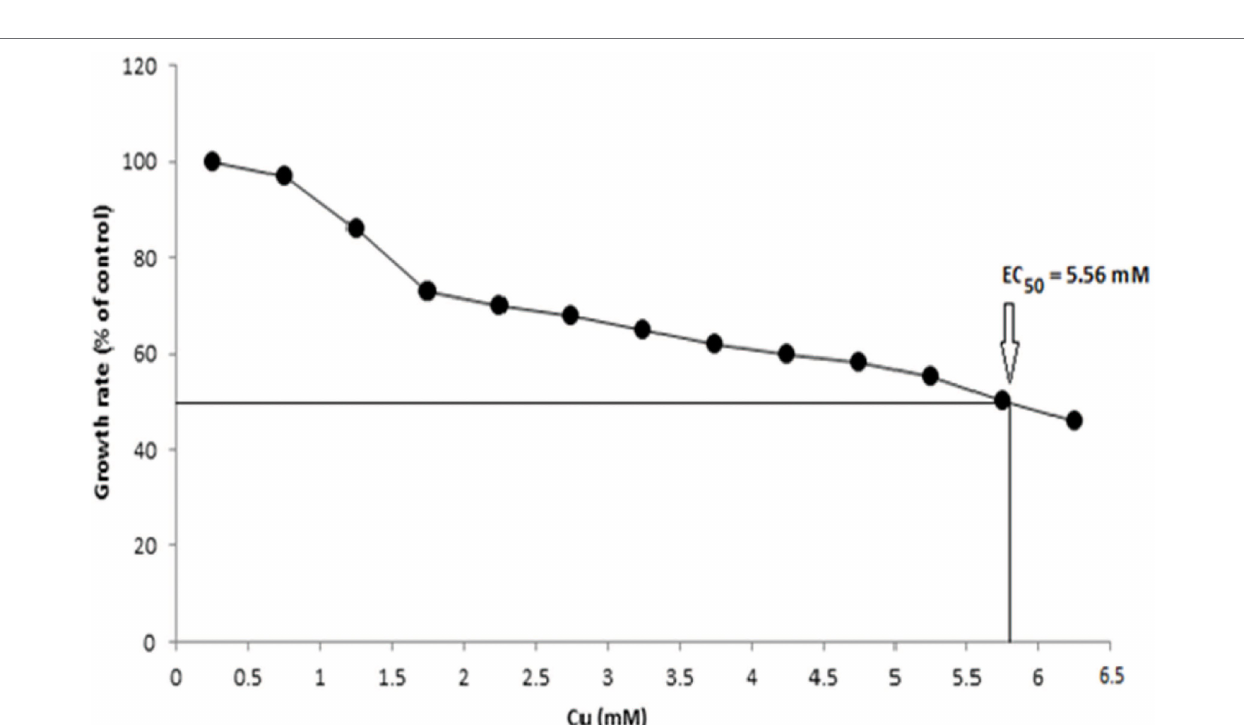
FIGURE 2 | EC 50 of B. altitudinis MT422188 with